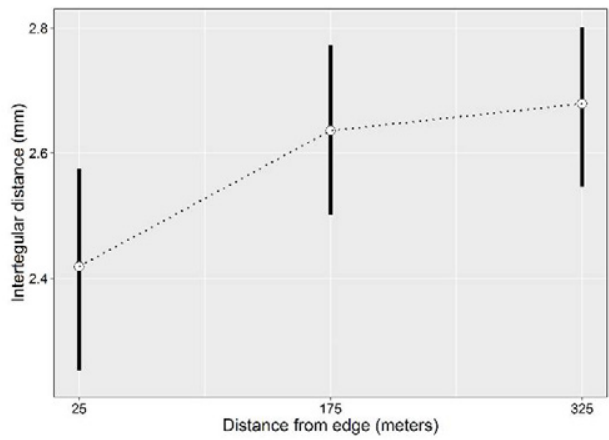
Fig 7 . Intertegular distance of bees in relation to distance from the sampled forest remnant (25 m, 175 m, 325 m). Points denote the mean; error bars denote the 95% confidence interval. All measures of dispersion estimated after 999 replications